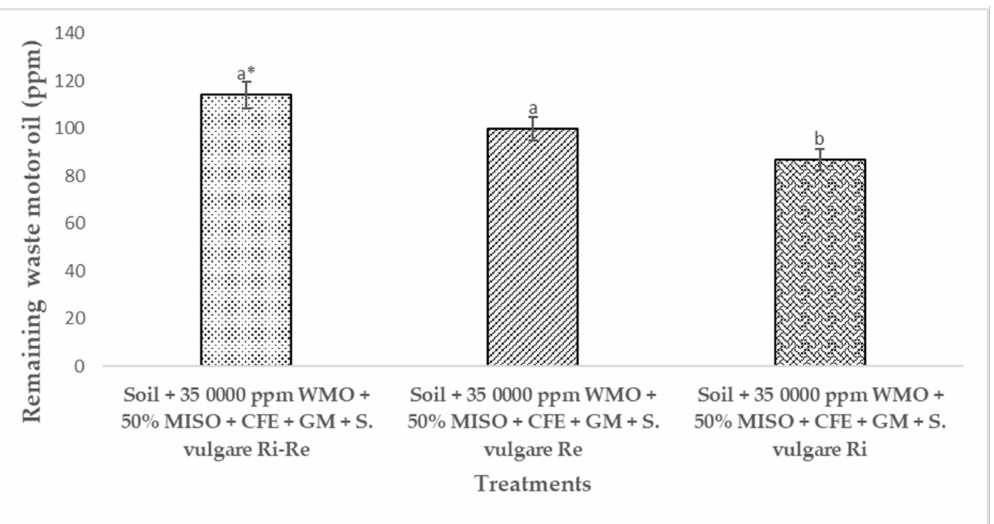
Figure 8. Concentration of waste motor oil in soil after 120 days of phytoremediation by Sorghum vulgare inoculated with Rhizophagus irregularis and/or Rhizobium etli . Notes: CFE = crude fungal extract, GM = green manure, MISO = mineral solution, Ri = Rhizophagus irregularis , Re = Rhizobium etli, WMO = waste motor oil. * Distinct letters indicate statistical difference ANOVA-Tukey ( p < 0.05). Number of repetitions ( n ) =